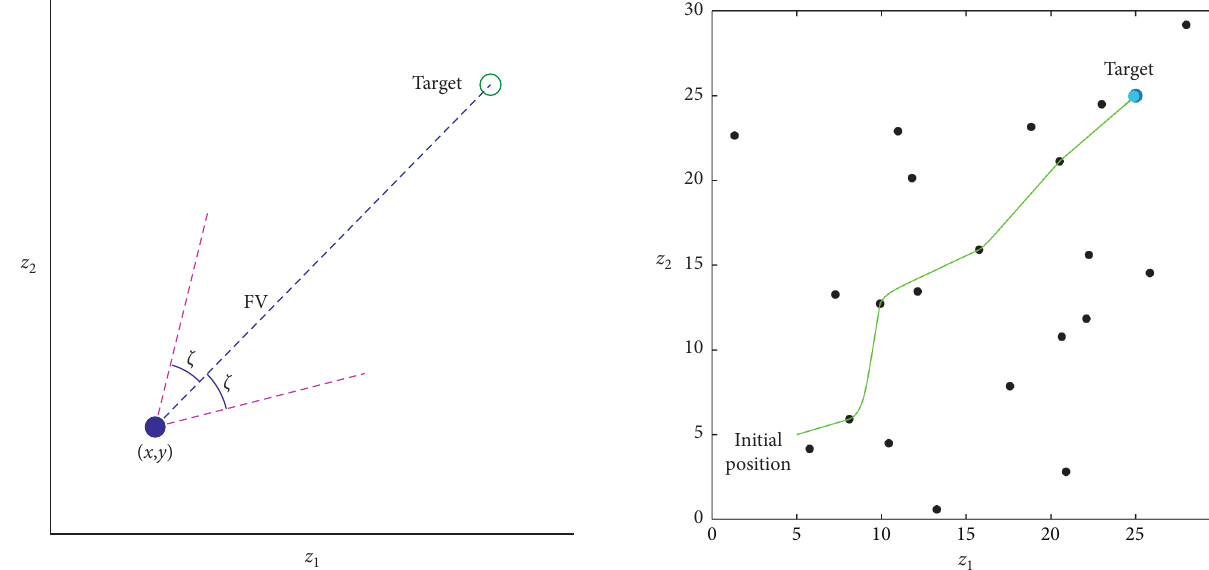
Figure 2: Schematic representation of the robot’s field of view ( FV )